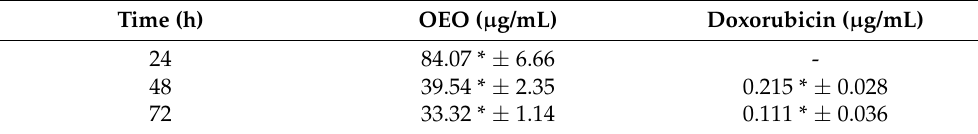
Table 2. Growth inhibitory effects (IC 50 values) of OEO and doxorubicin on the MCF-7 cell line after 24, 48, and 72 h of